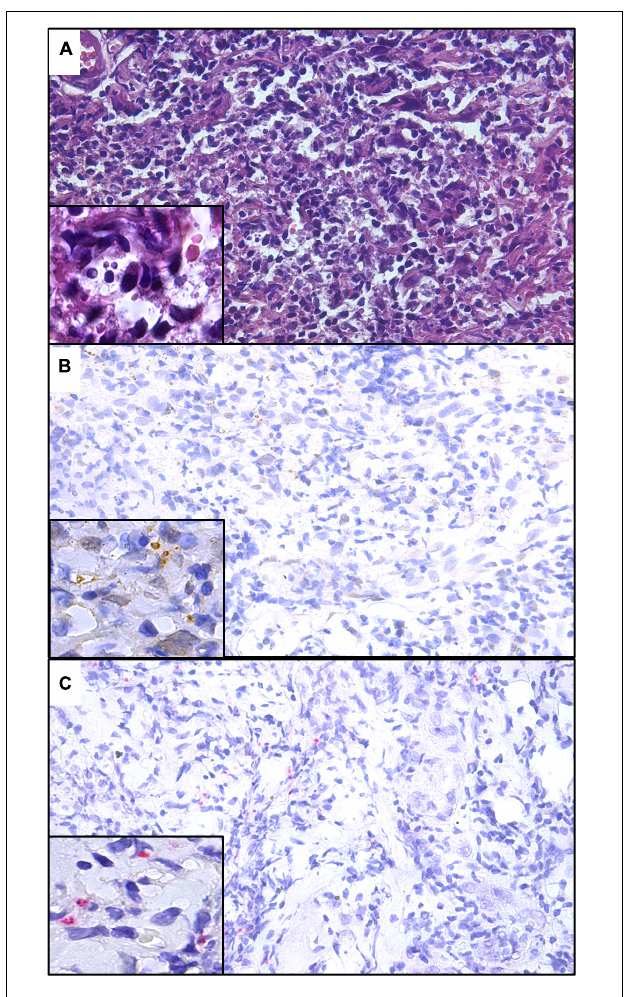
FIGURE 6 | Histological sections of skin lesions from patients with low parasite burden, stained by hematoxylin–eosin (A) , IHC-HRP (B) , and IHC-AP (C) (280 × ). Detail showing amastigote within parasitophorous vacuoles (700 × ).